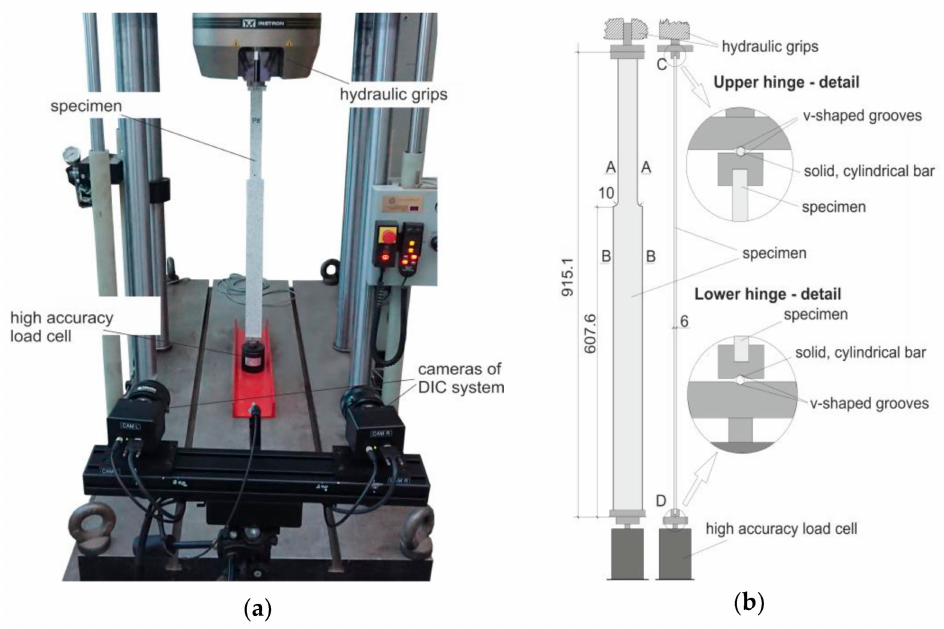
Figure 11. The test rig: ( a ) General view; ( b ) Details. The compressive force was generated by the downward movement of the upper hydraulic grips. The value of the force was measured by the load cell placed beneath the lower hinge of the specimen. Horizontal and vertical displacements of specimens during the test were measured by means of the noncontact optical DIC (digital image correlation) system. To this end, the specimen’s surface was covered by black, speckle pattern visible in Figure 11a.